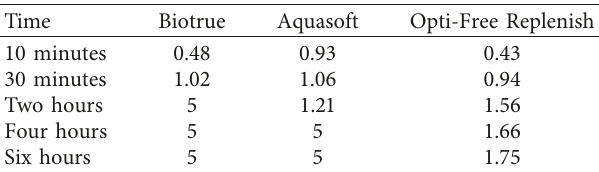
Table 3: Log reduction per solution per time interval for Staph-